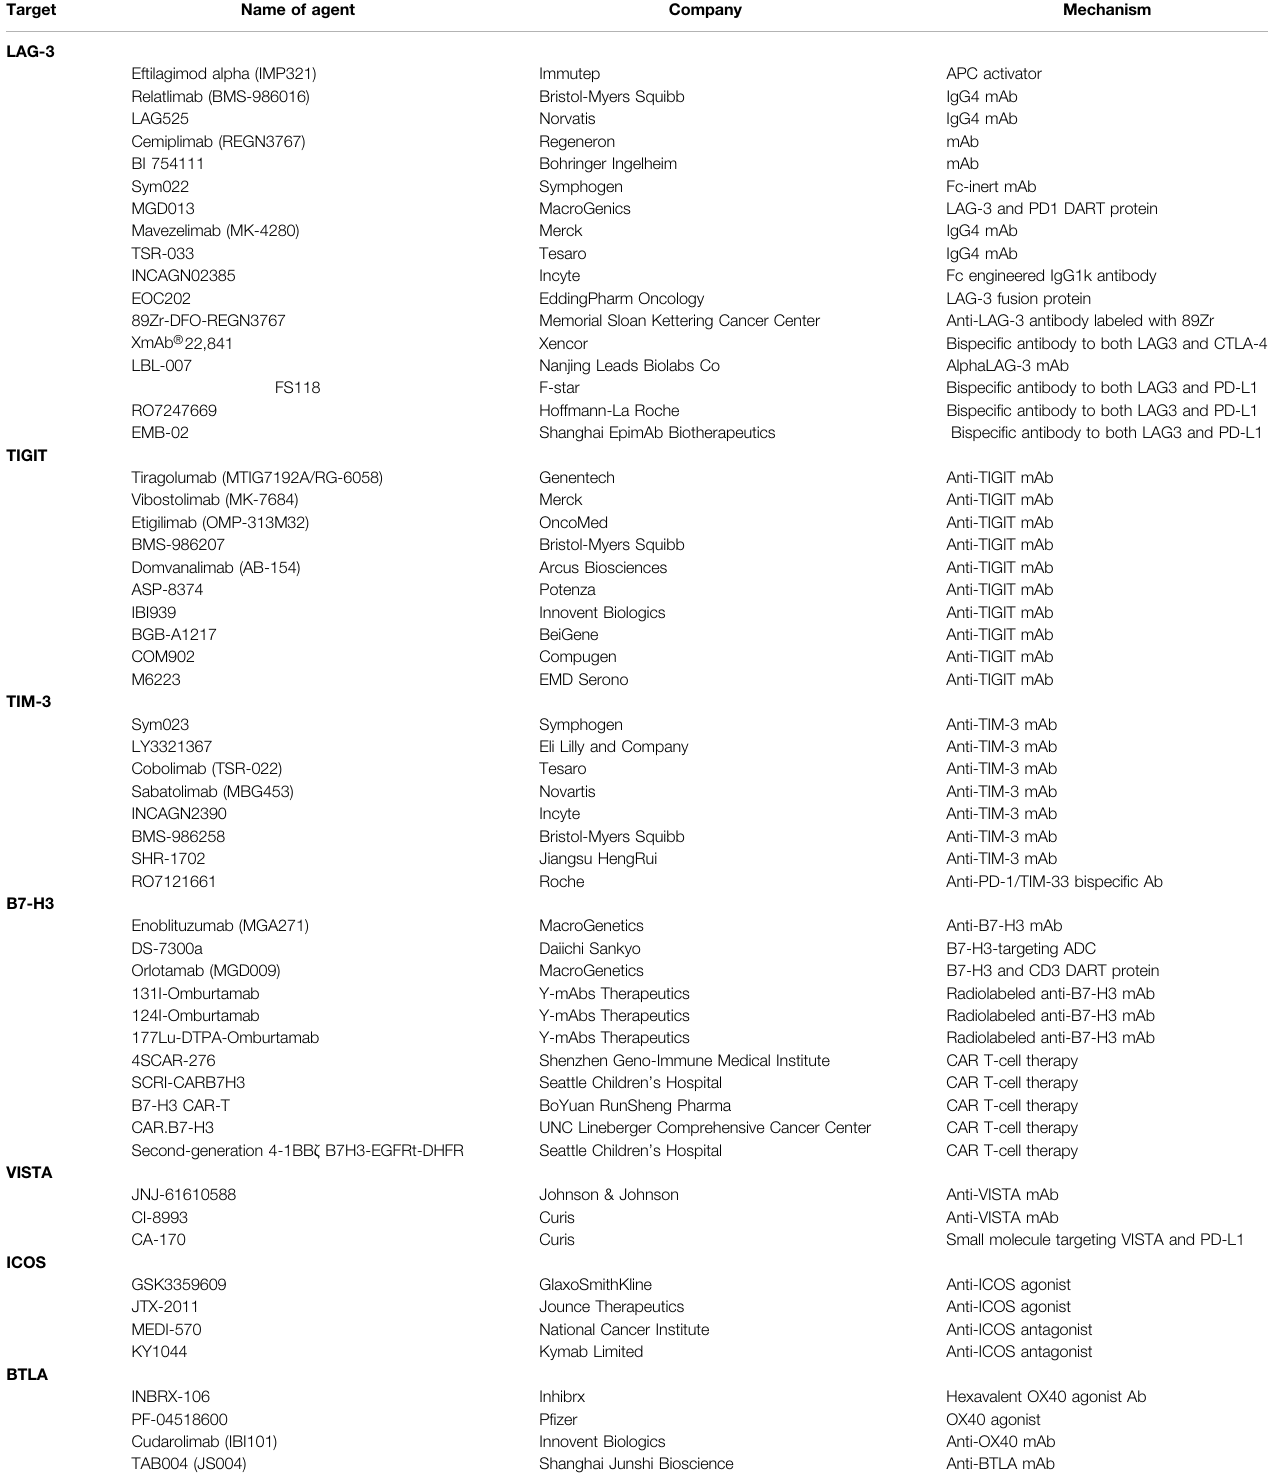
TABLE 2 | Emerging immune checkpoint inhibitors and their